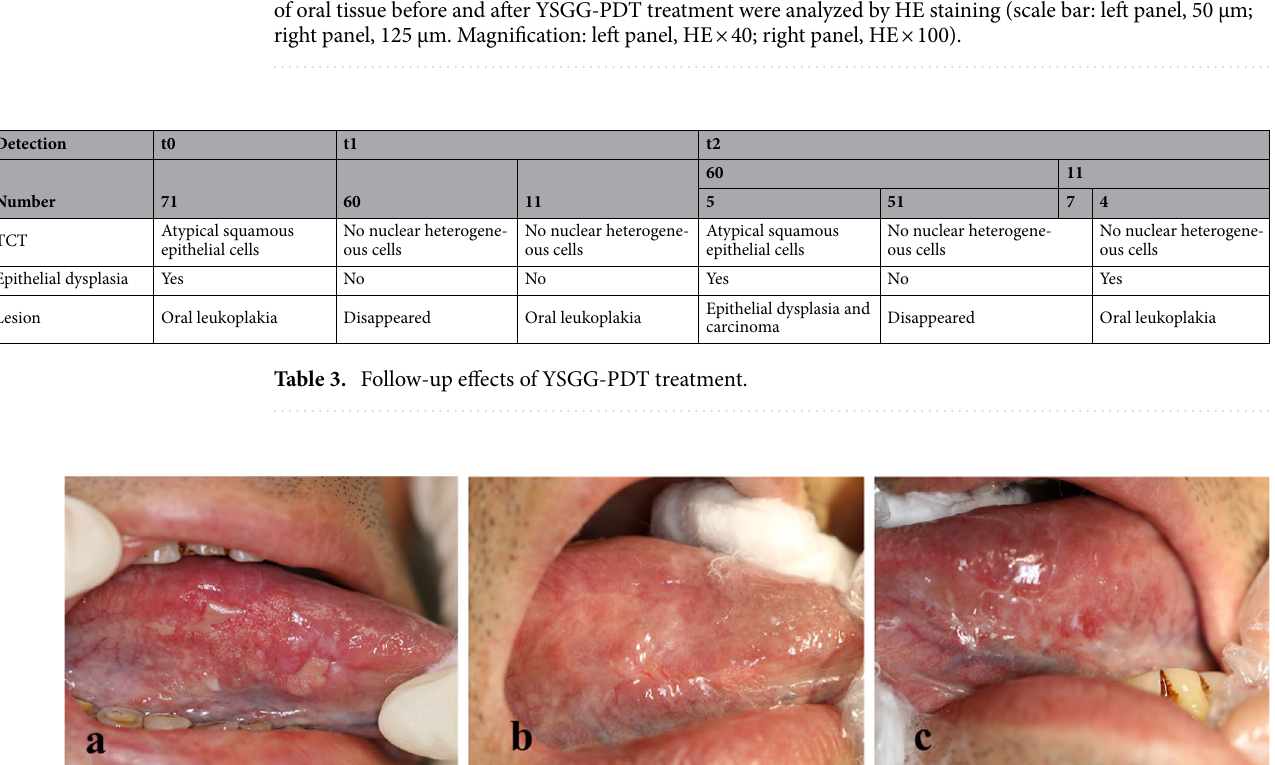
Figure 3. HE stains of patients of preoperative ( a ) and postoperative ( b ) treatment. The pathological changes of oral tissue before and after YSGG-PDT treatment were analyzed by HE staining (scale bar: left panel, 50 μm;